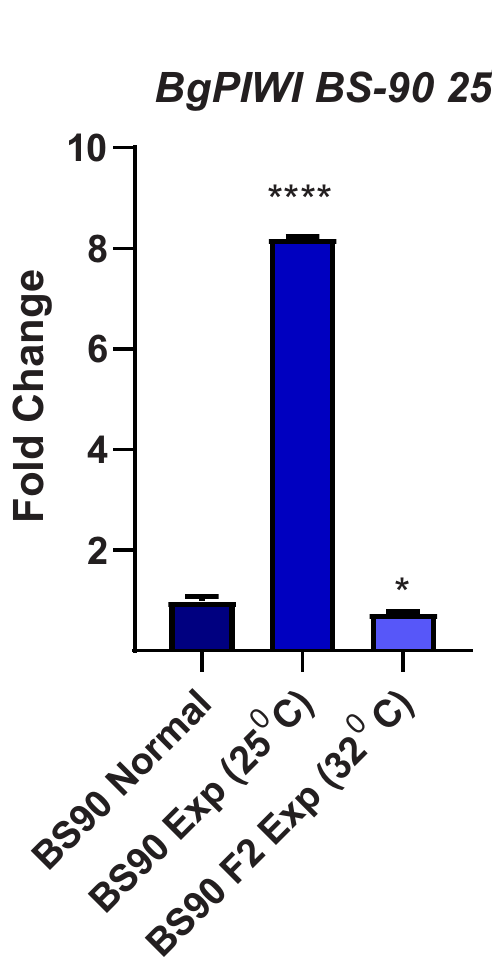
Fig 7. qPCR analysis of RNA from either non permissive (25˚C) resistant BS-90 (blue histogram) or permissive (32˚C) susceptible BS-90 (gray histograms) juvenile snails unexposed (normal) or exposed for 2hr to S . mansoni miracidia. Histograms show expression of the BgPiwi encoding transcript in these snails residing at different temperatures. Note the significant induction (8-fold change) in 25˚C non-permissive BS-90 snails compared the down regulation of the transcript in permissive BS-90 snails residing at 32˚C after parasite infection. Fold change was determined as described in MATERIALS and METHODS. Significant expression normalized against expression of the myoglobin encoding transcript was measured by 2-way ANOVA and is indicated by number of asterixis on each histogram where ���� , indicates the most significant value p � 0.0001, ��� p � 0.001, �� p � 0.01, � p � 0.05, ns p >